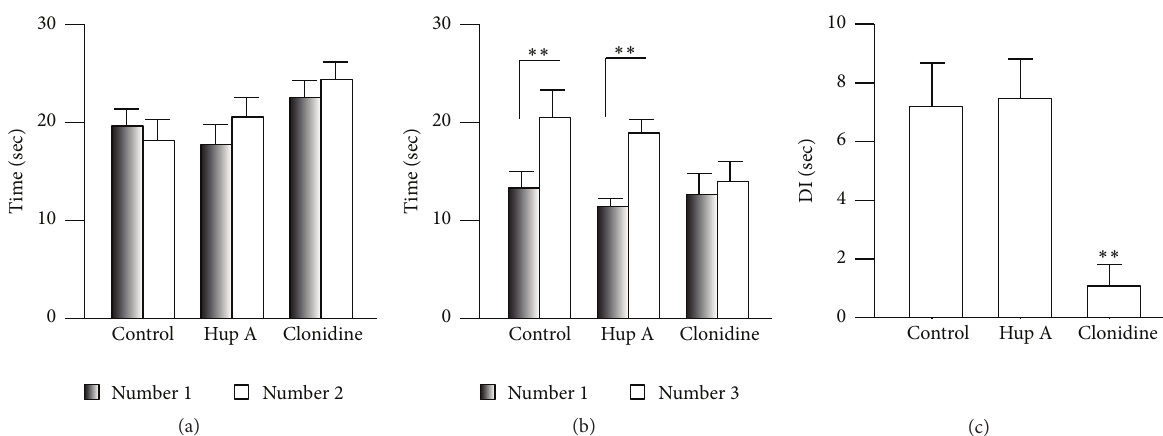
Figure 6: Hup A did not affect learning in mice. (a) Exploration times for the two identical bottles in each group (two-way RM ANOVA, objects: 𝐹 1;43 = 2.19 , 𝑃 > 0.05 ; groups: 𝐹 1;43 = 1.86 , 𝑃 > 0.05 , 𝑛 = 7 for control and clonidine group, 𝑛 = 8 for Hup A group). (b) The control and Hup A groups spent more time exploring the novel object (two-way RM ANOVA, objects: 𝐹 1;43 = 1.04 , 𝑃 > 0.05 ; groups: 𝐹 1;43 = 51.05 , 𝑃 < 0.01 , 𝑛 = 7 for control and clonidine group, 𝑛 = 8 for Hup A group, ∗∗ 𝑃 < 0.01 under SNK test). (c) The discrimination index did not differ between the control and Hup A groups (one-way ANOVA, 𝐹 2;21 = 7.10 , 𝑃 < 0.01 ; ∗ 𝑃 < 0.05 under SNK test). DI indicates discrimination